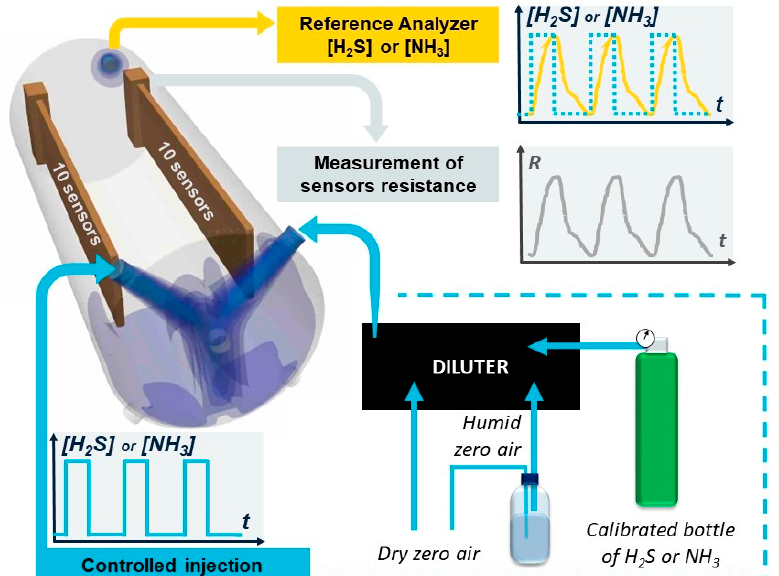
Figure 1. Experimental set-up to characterize the evolution of the resistance of 20 sensors in a controlled environment. The exposure chamber was maintained at a constant temperature (20–22 ◦